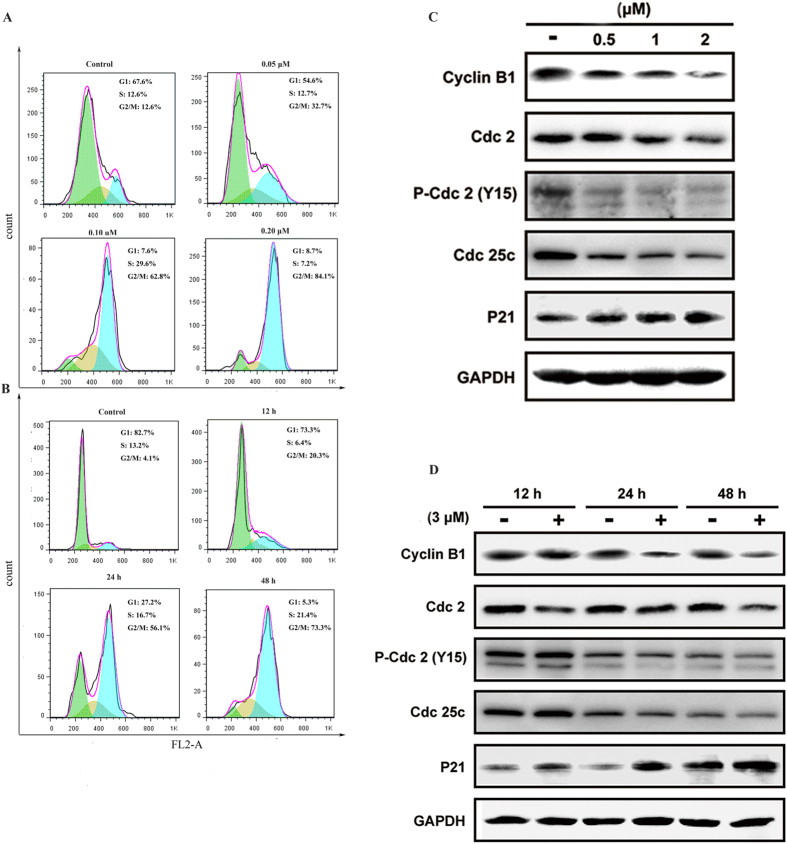
Compound 7 induces G2/M phase arrest and regulates the G2/M-related protein expression in A549 cells.(A) Cells treated with 0, 0.01, 0.1, and 0.2 μM compound 7 for 48 h were collected and processed for analysis. (B) Cells treated with 0.18 μM compound 7 for different times (0, 12, 24, and 48 h) were collected and analyzed. The percentage and images of cell cycle distribution in G2 phase were shown as representative of three independent experiments. (C) Western blot analysis of the levels of the G2/M-related proteins Cyclin B1, Cdc25c, Cdc2, and P21. A549 cells were treated with or without compound 7 at 0.5 μM, 1.0 μM, and 2.0 μM for 48 h. (D) Western blot analysis of the levels of the G2/M-related proteins Cyclin B1, Cdc25c, Cdc2, and P21. A549 cells were treated with or without 3.0 μM compound 7 for 12 h, 24 h and 48 h.